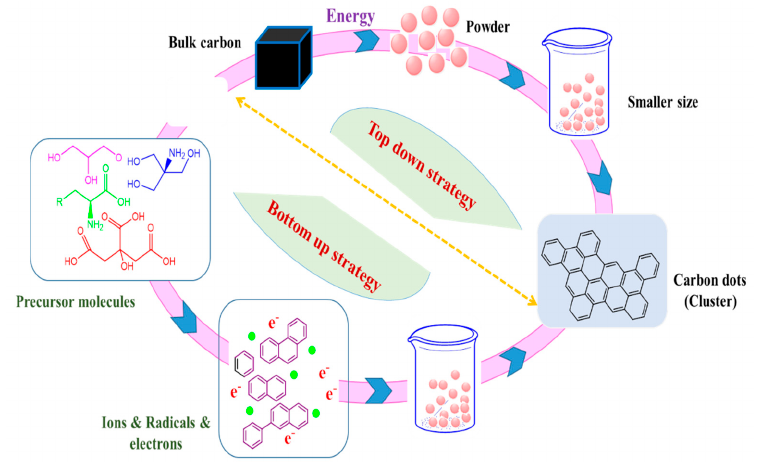
Figure 2. Generation of carbon dots by well-known Top-down and bottom-up approaches.